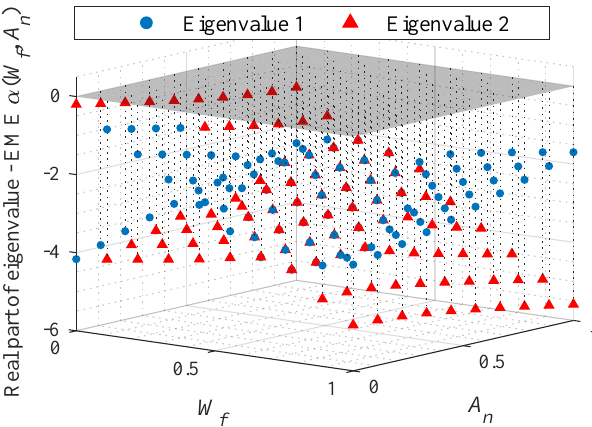
(cid:104) (cid:105) W f , A n )